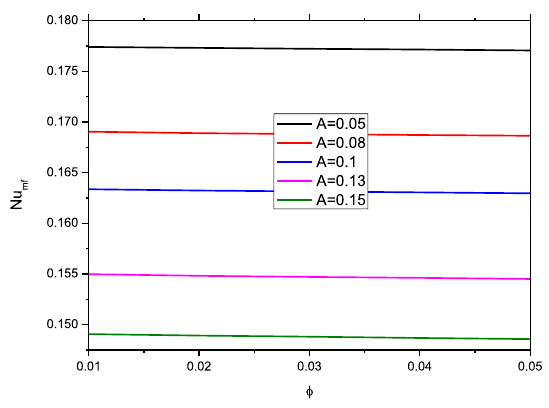
Fig. 19 Wave amplitude parameter profiles of the fluid average Nusselt number for TiO –Cu/water hybrid nanofluid at Ha = 10 , 2 Q = 1 , Da = 10 – 3 , Ri = 1 , Gr = 1 , H * = 10 , R = 0 . 5 , ε = 0 . 5 , γ = 0 . 5 , Φ = π/ 3 , c d λ = , α = , ϕ = ϕ = ϕ / 2 , ϕ = 0 . Cu TiO 2